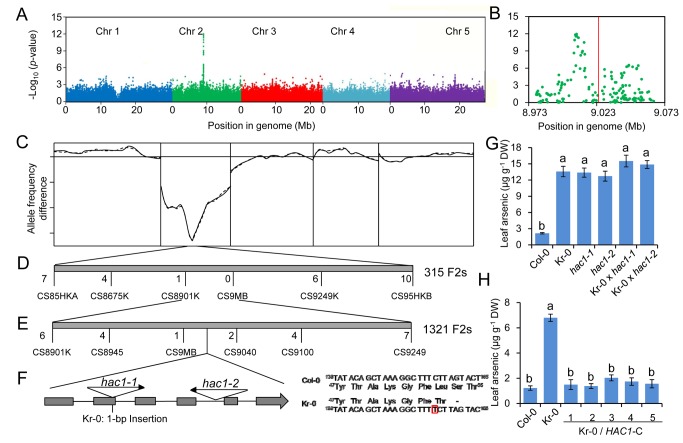
The High Arsenic Content 1 (HAC1) gene controls natural variation in leaf arsenic in A. thaliana.(A) Genome-wide association analysis of leaf arsenic concentration at 213,497 SNPs across 377 A. thaliana accessions using a mixed model analysis with correction for population structure. (B) A detailed plot of the peak region on chromosome 2 is shown with the location of HAC1 indicated by the vertical red line. (C) DNA microarray-based bulk segregant analysis of the high leaf arsenic phenotype of Kr-0 using phenotyped F2 progeny from a Kr-0×Col-0 cross genotyped using the 256K AtSNPtilling microarray. Lines represent allele frequency differences between high and low leaf arsenic pools of F2 plants at SNPs known to be polymorphic between Kr-0 and Col-0 (Solid line = sense strand probes, dashed line = antisense strand probes). (D) The causal gene was mapped between CAPS makers CS8901K and CS9249K using 315 F2 plants. (E) Fine mapping narrowed hac1 down to a 40 kb interval between markers CS9M and CS9040 using 1,321 F2 plants. Numbers below the horizontal line in (D) and (E) represent the number of recombinants between the indicated marker and hac1. (F) Gene structure of different HAC1 alleles. Arrows indicate T-DNA insertion sites for hac1-1 (GABI_868F11) and hac1-2 (SM_3_38332). Grey boxes indicate exons, and black lines indicate introns. The causal polymorphism in Kr-0 is shown to the right. (G) Leaf arsenic concentrations of different HAC1 alleles and their F1 progenies indicate through deficiency complementation that HAC1 is the causal gene for the high leaf arsenic in Kr-0. (H) Kr-0 was transformed with the Col-0 genomic DNA fragment of HAC1 (including 1.5Kb promoter sequence) and shown to complement the high leaf arsenic of Kr-0 to Col-0 levels in five independent transgenic lines (represented by numbers above the line in the x-axis legend), confirming HAC1 is the causal gene for high leaf arsenic in Kr-0. Data in (G) and (H) represents the means ± S.E. (n = 4–12 independent plants per genotype). Letters above bars indicate statistically different groups using a one-way ANOVA followed by least significant difference (LSD) test at the probability of p<0.05. All leaf arsenic concentration data are accessible using the digital object identifiers (DOIs) 10.4231/T9H41PBV and 10.4231/T9VD6WCJ (see http://dx.doi.org/) and available in Data S2.